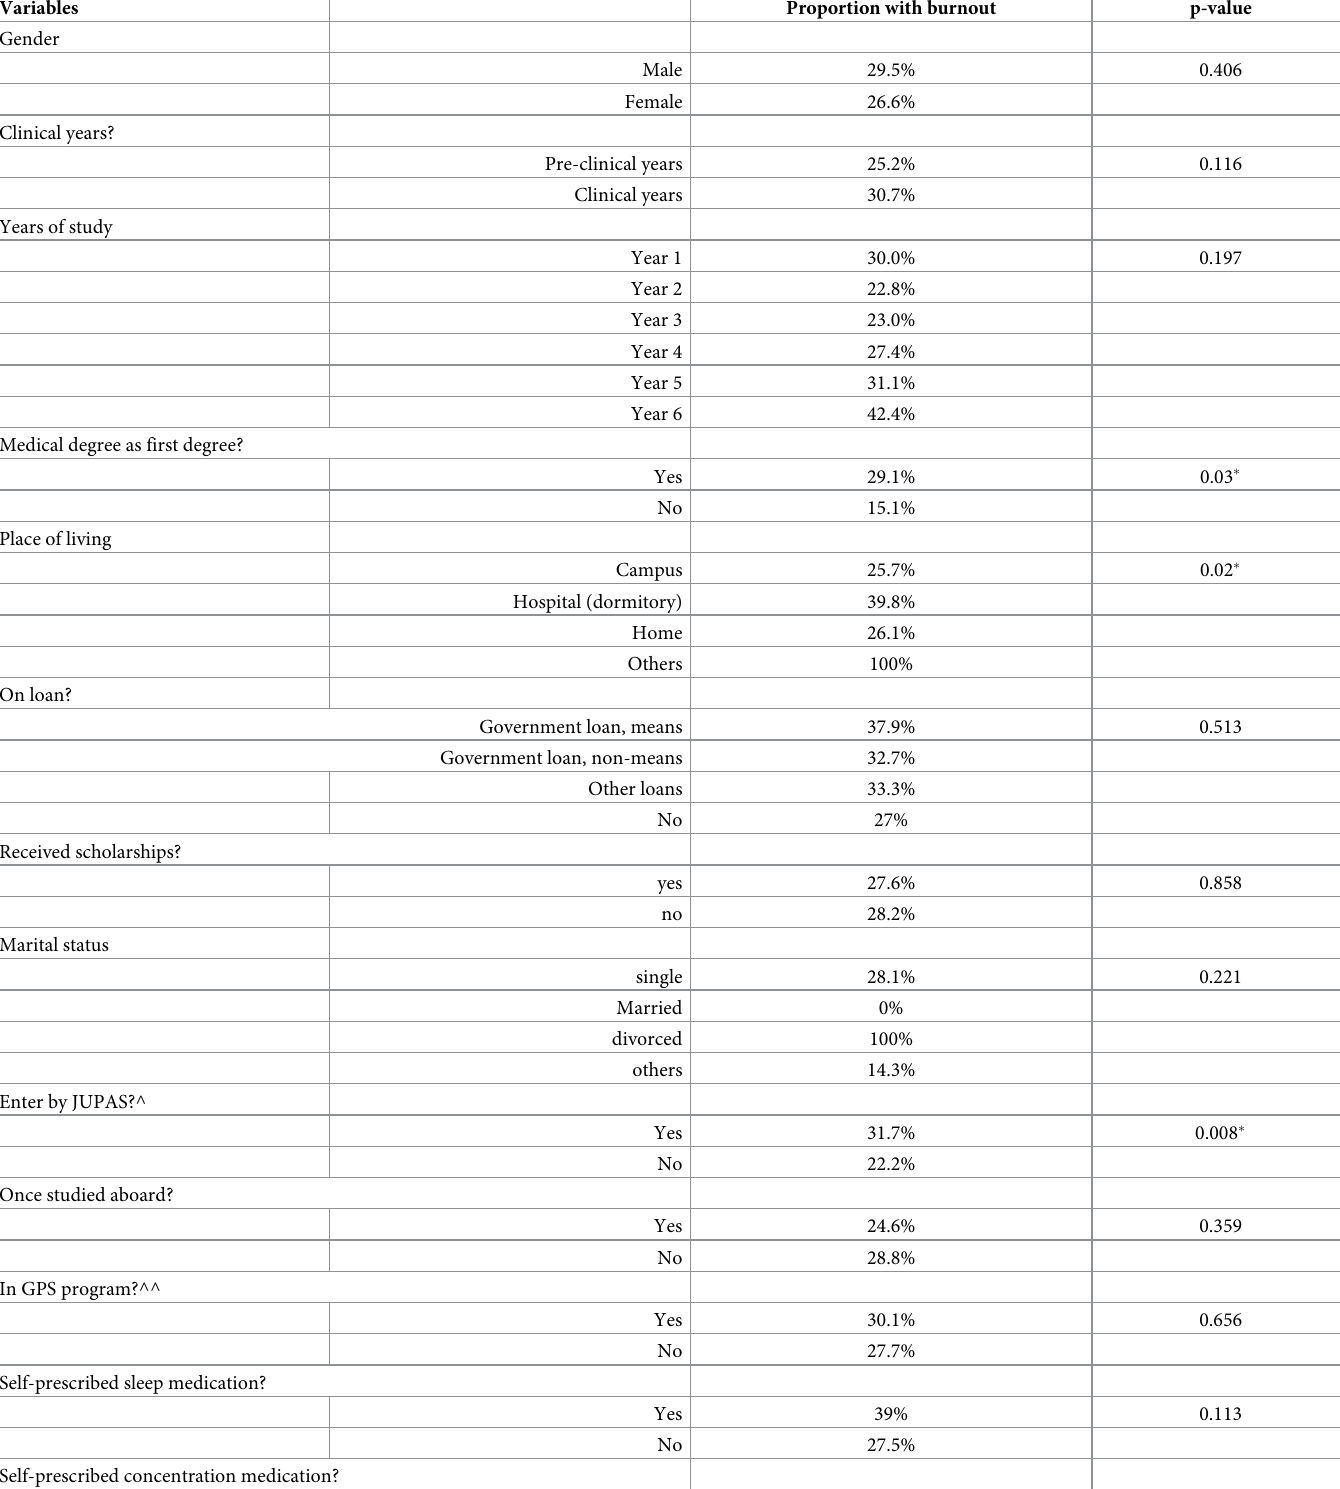
Table 3. Relationship between demographics/lifestyle factors (categorical data) and